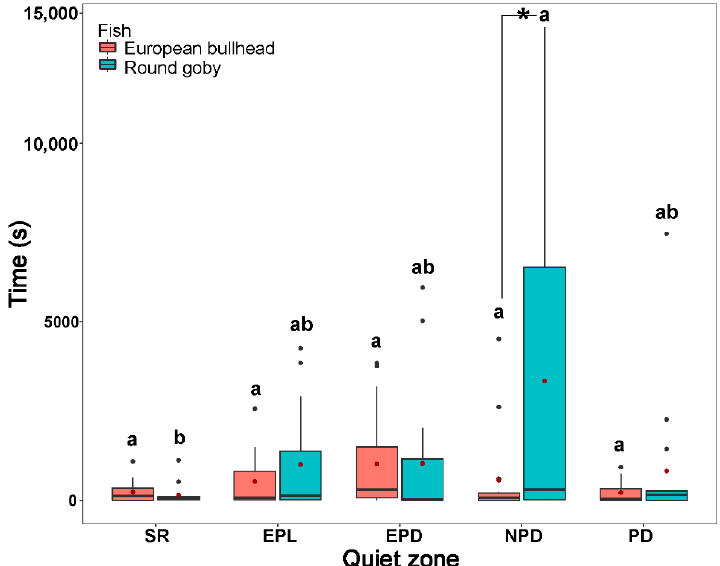
Figure 4. The time in shelter and quiet zones during the stress response period (SR), exploration period in light conditions (EPL), exploration period in dark conditions (EPD), normal behavior period in darkness (NPD), and normal behavior period in light (NPL) by the European bullhead and the round goby in a 28 h trial. Box limits correspond to upper (Q3—75%) and lower (Q1—25%) quartiles, horizontal bar to the median, and red dot to the mean. Outliers are indicated by points (min = Q1 − 1.5 * IQR; max = Q3 + 1.5 * IQR). Different letters indicate significant intraspecific differences ( α = 0.05). Asterisks indicate significant interspecific differences.